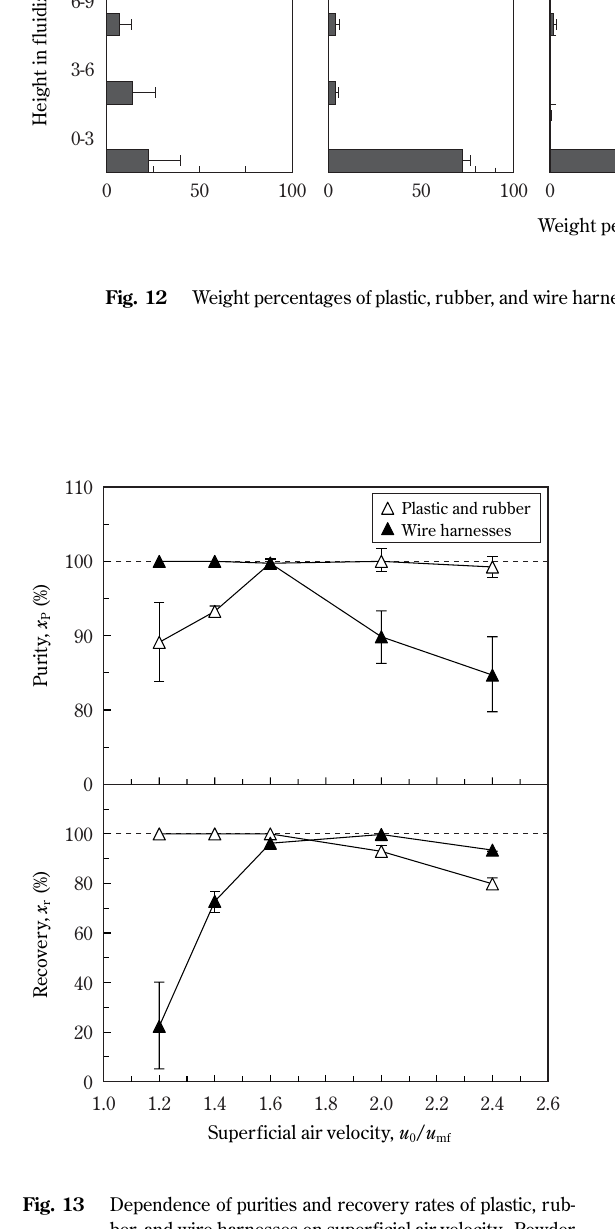
Fig. 13 Dependence of purities and recovery rates of plastic, rub- ber, and wire harnesses on superficial air velocity. Powder is zircon